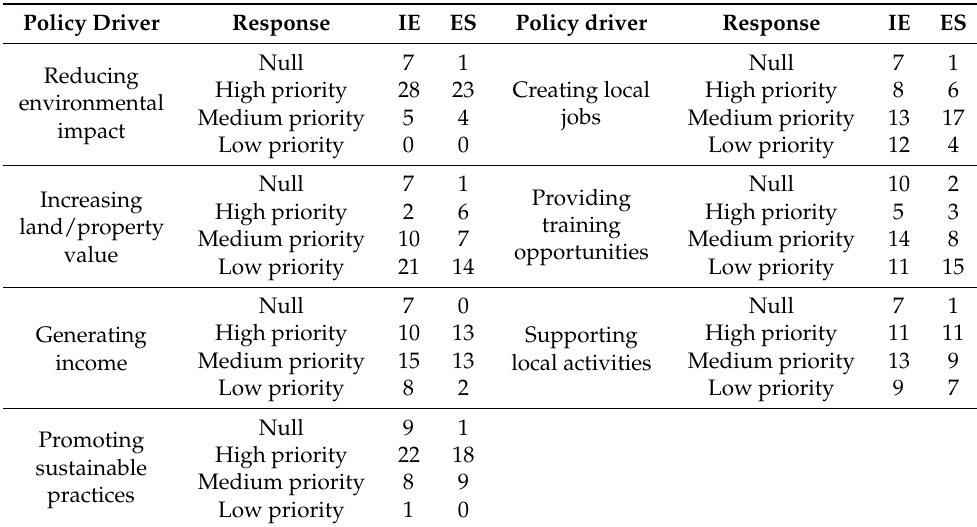
Table 4. Policy drivers for MHP in Ireland (IE) and Spain